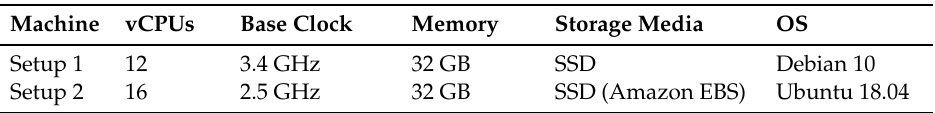
Table 1. The specifications of the two machines used to benchmark database performance.